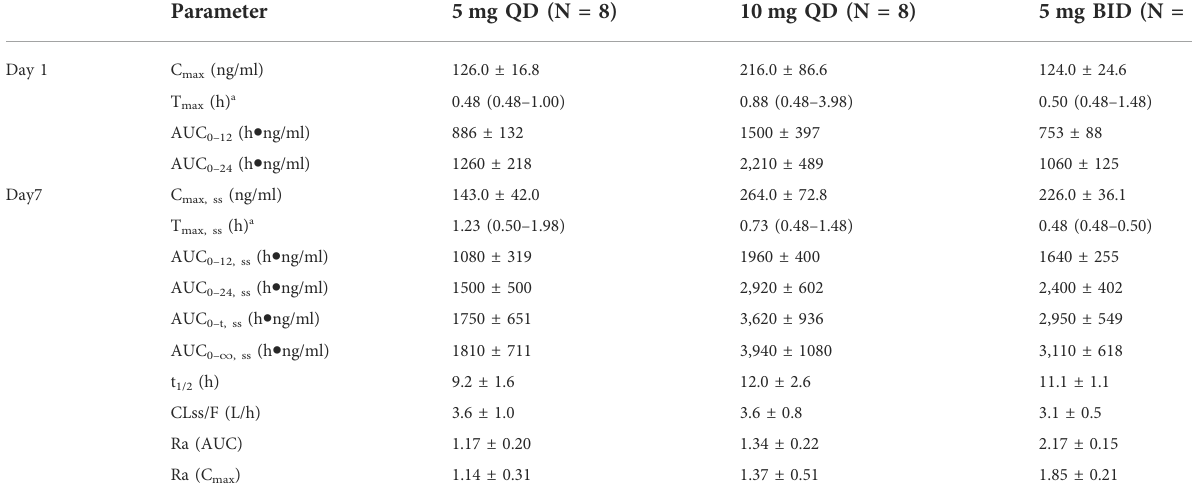
TABLE 3 The primary pharmacokinetic parameters of WXFL10203614 on day 1 and 7 in the multiple-dose study.